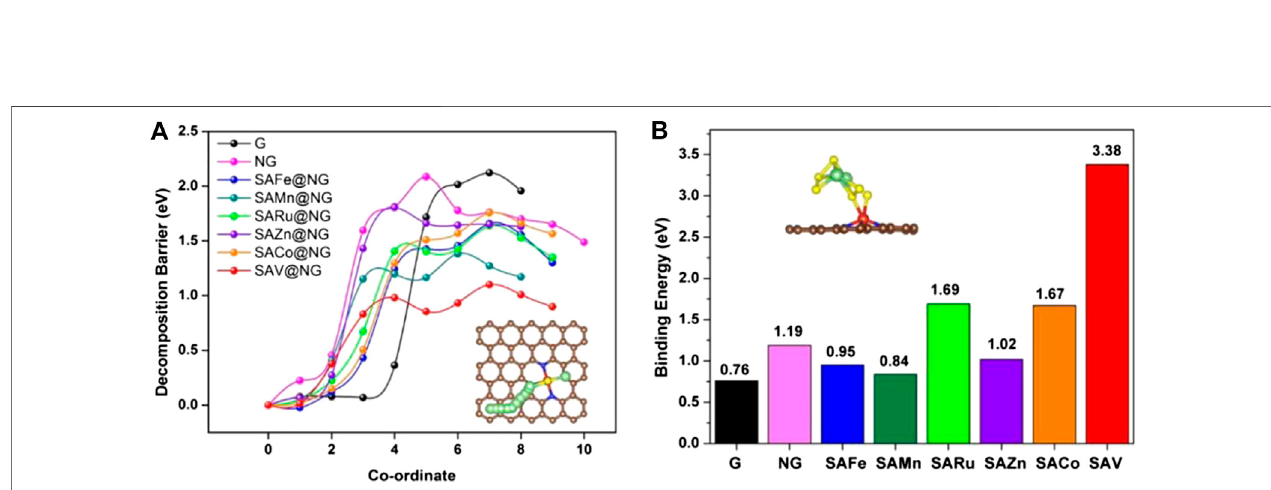
FIGURE 4 | (A) Decomposition barriers of Li 2 S (B) binding energy of Li 2 S 6 on the graphene, NG, SACo@NG, SAV@NG, SAFe@NG, SAMn@NG, SARu@NG, and SAZn@NG, respectively. Reproduced with permission from Zhou et al. (2019). Copyright © 2019 American Chemical Society.